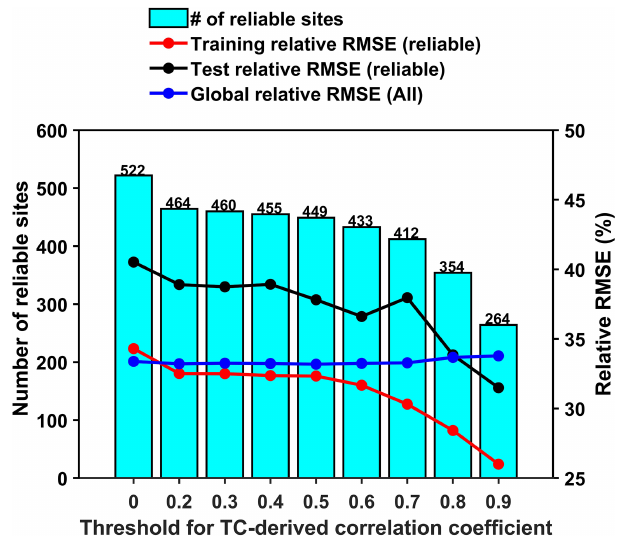
Figure 15. Effect of extended triplet collocation (ETC)-derived cor- relation coefficients on the number of reliable sites and the corre- sponding RCNN’s training, test, and global accuracies.